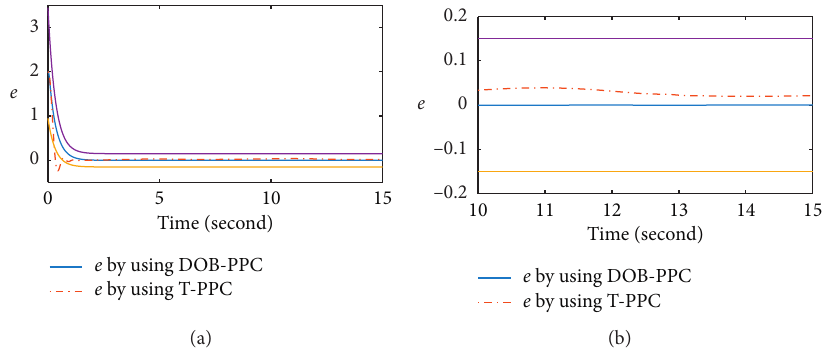
Figure 2: Tacking error e of system (47) for two methods in time period (a) [0, 15s]; (b) [10s,